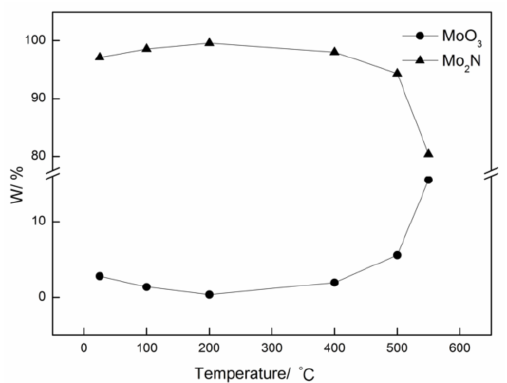
Figure 6. The weight fractions of Mo 2 N and MoO 3 on the wear tracks as a fraction of testing temperatures.